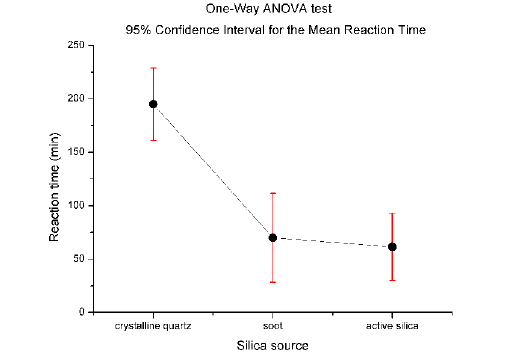
Figure 11. ANOVA test of the reaction times, with 95% confidence interval (CI) for mean reaction time. The lines connecting dots and the horizontal lines are guides for the